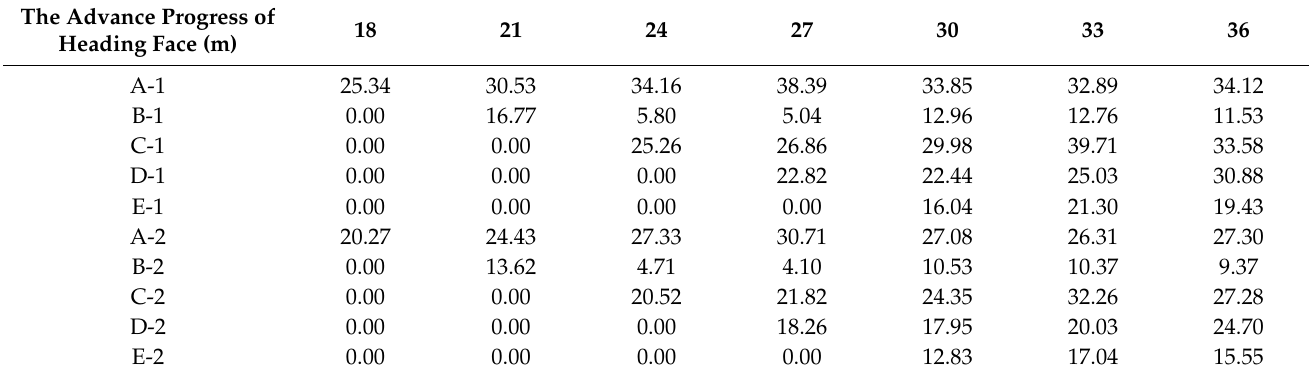
Table 16. Bending moment trend of secondary lining arch crown (Unit: kN).